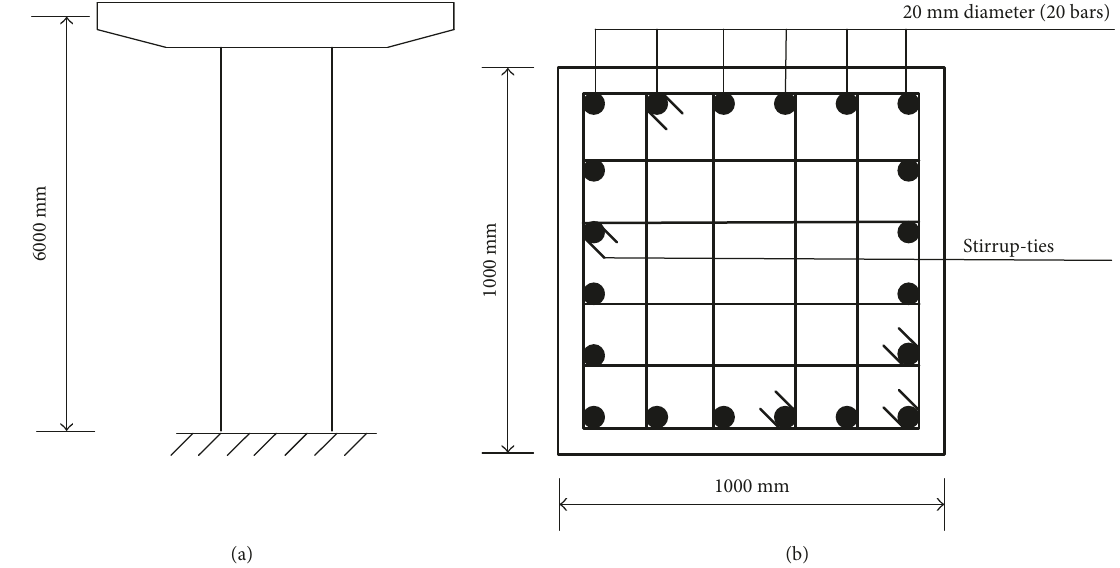
Figure 15: Single pier of the bridge. (a) Single pier. (b) Cross section and reinforcement details.